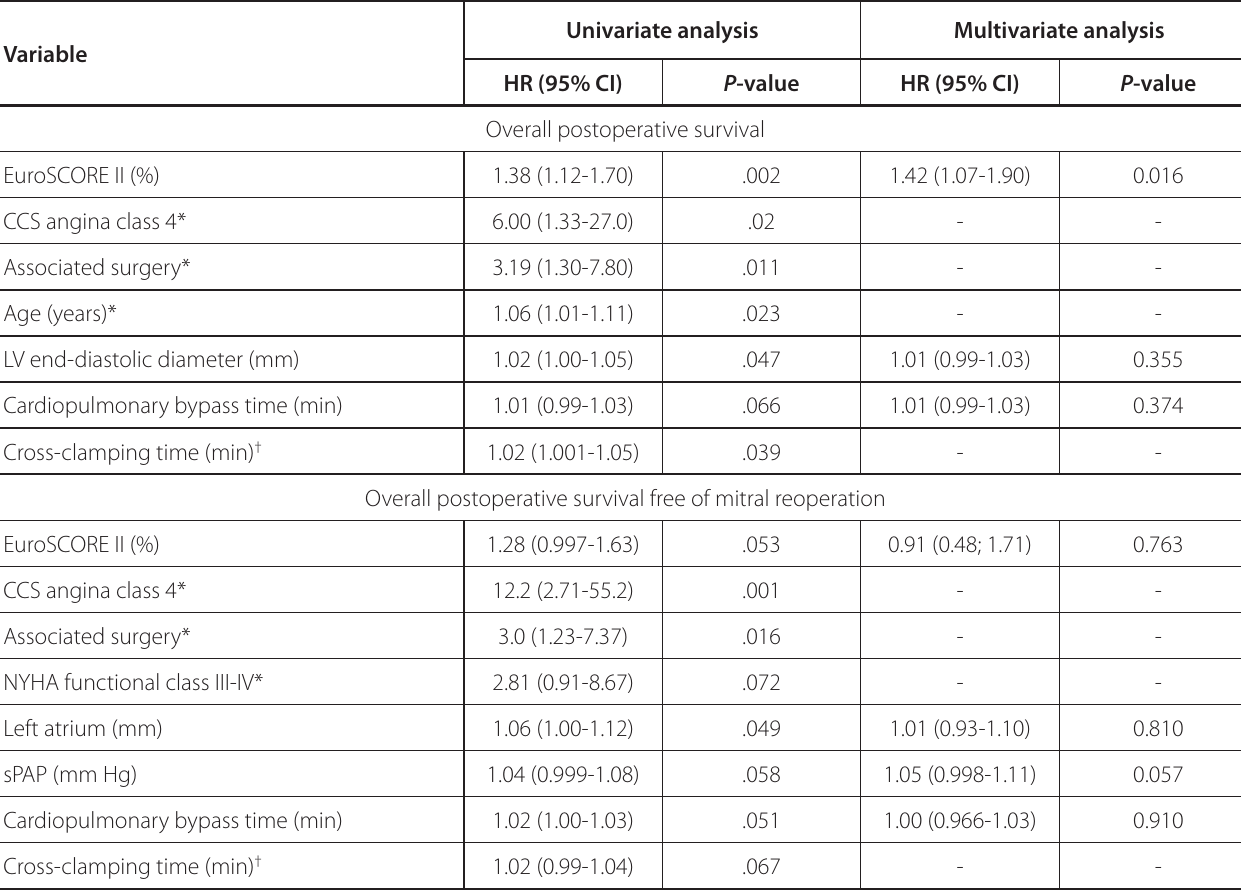
Table 3 . Univariate and multivariate